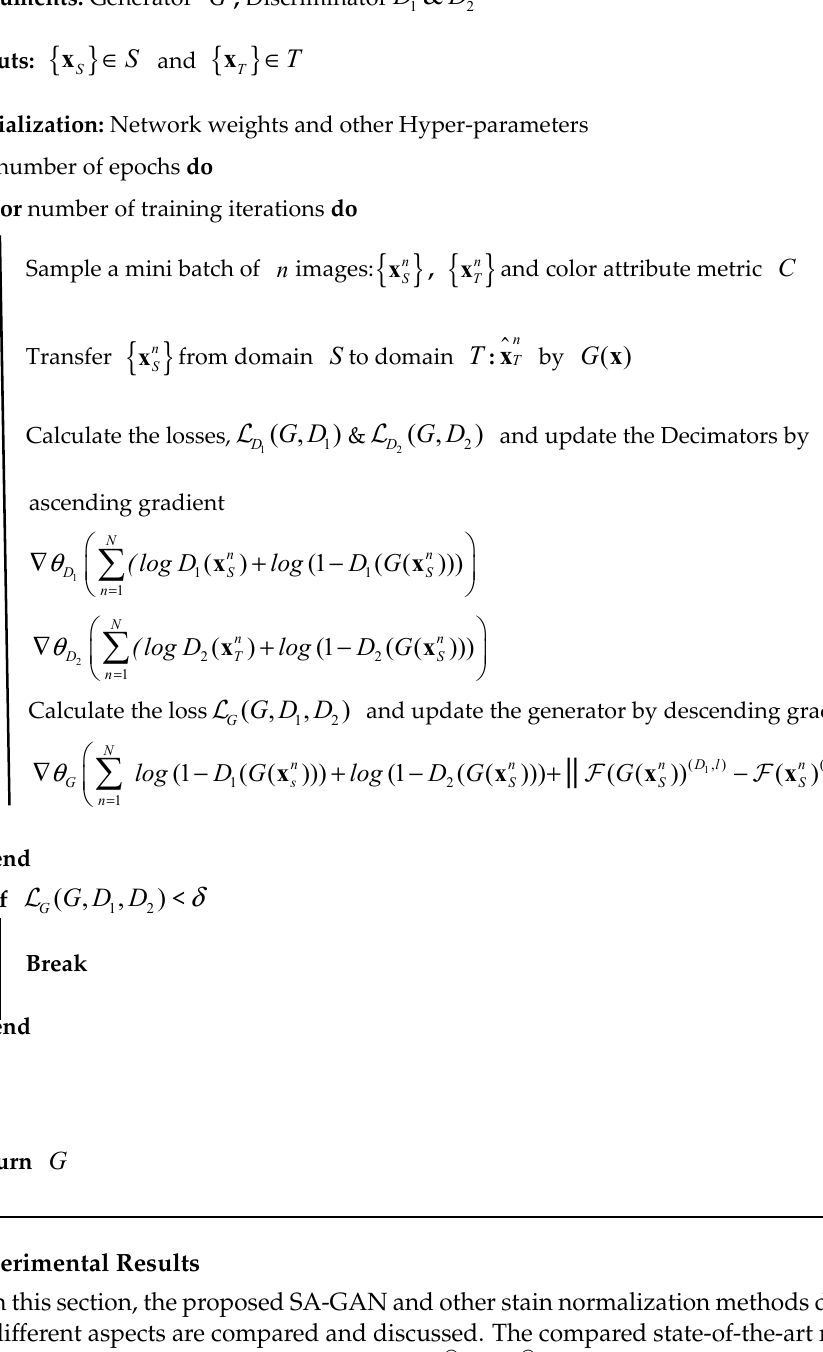
Algorithm 1 SA-GAN Optimization Algorithm